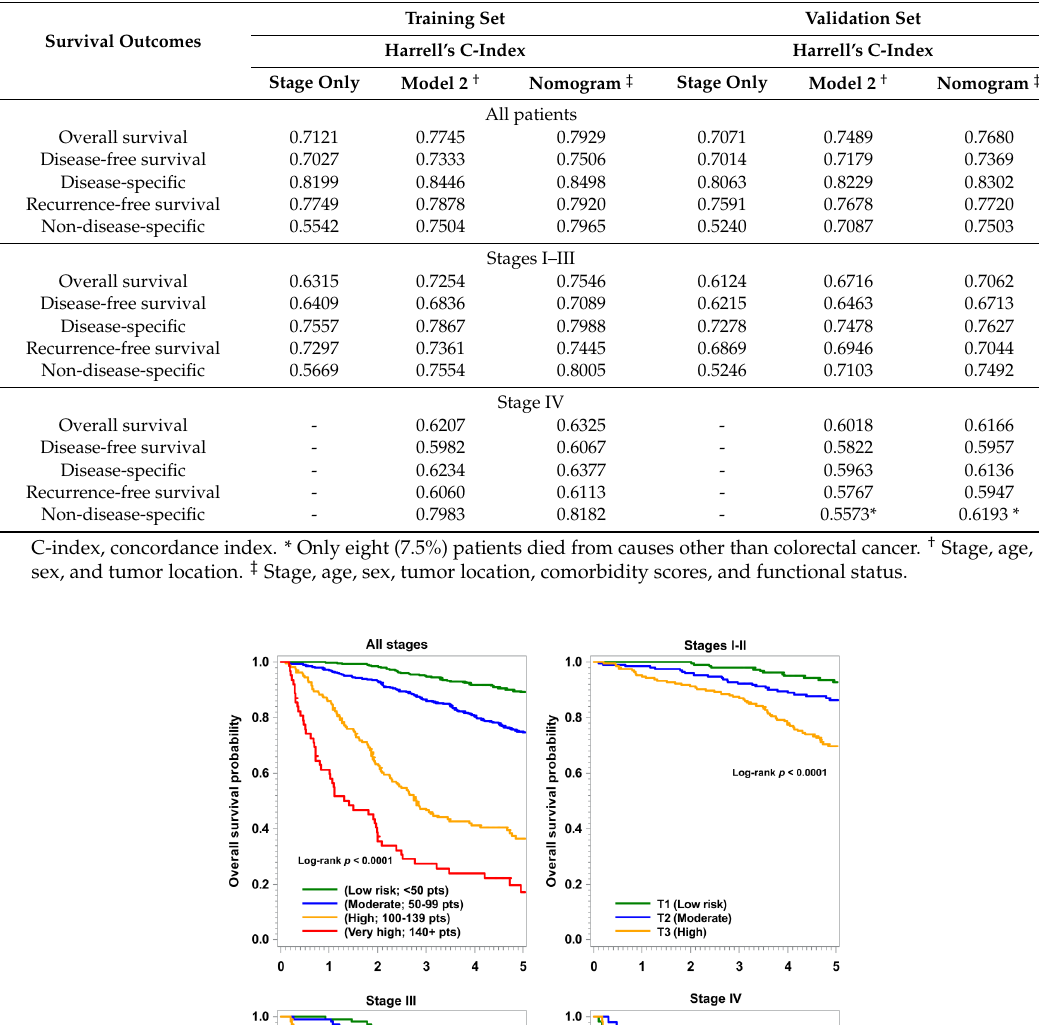
Table 3. Comparison of concordance C-indexes of various prediction models, overall and according to tumor stage.